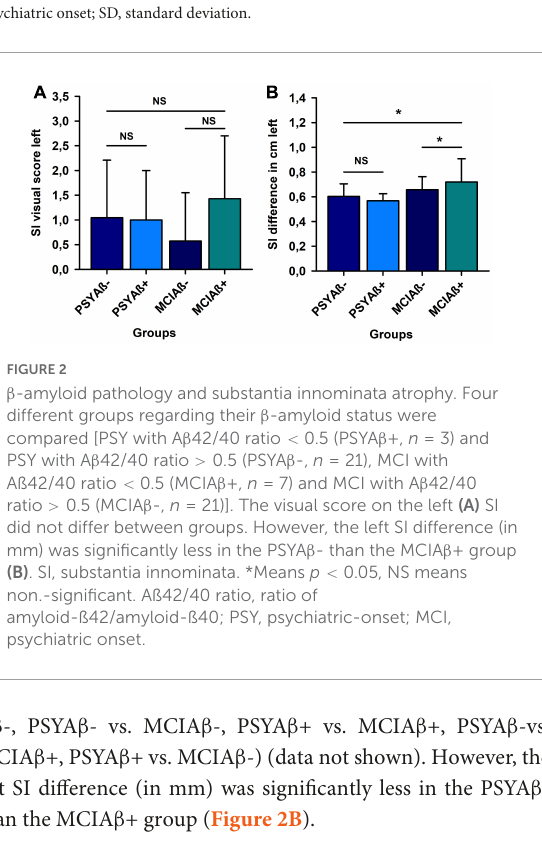
The single score ICC (A, 1) was 0.889 with a 95%- Confidence Interval of